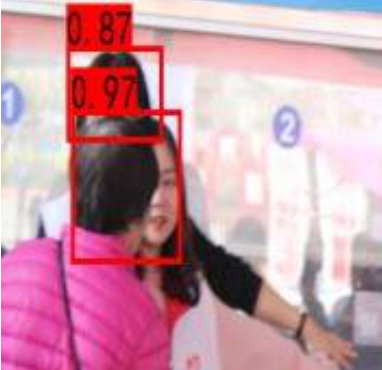
Figure 2. A missed detection happened using NMS.